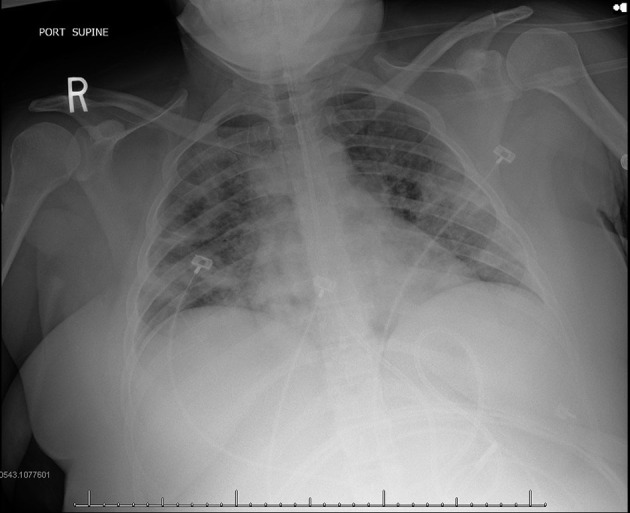
COVID-19 positive patient chest x-ray (CXR). This figure is original and illustrates the findings from (78). It demonstrates bilateral predominately mid to lower lung field airspace opacities.